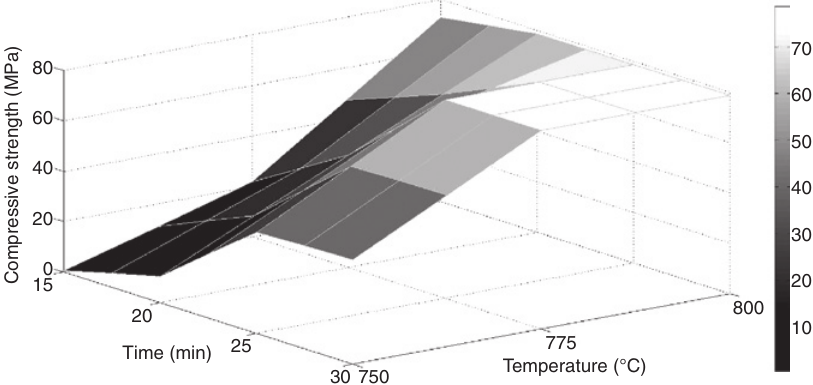
Figure 12: MG80 compressive strength as a function of sintering temperature and time.